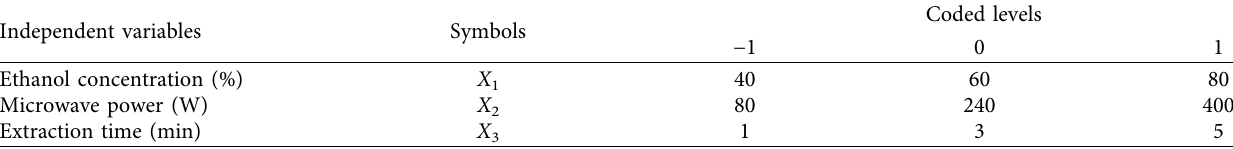
Table 1: Three levels of the three variables of the extraction